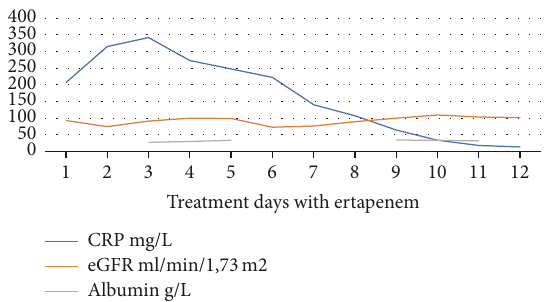
Figure 1: Values of C-reactive protein (CRP), estimated glomerular filtration (eGFR), and serum albumin during the treatment with